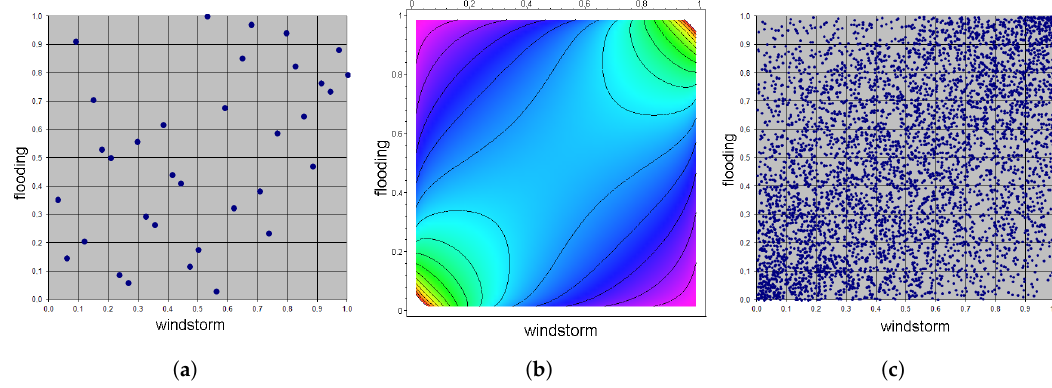
Figure 6. Plots for the Gaussian copula in Example 3. ( a ) Support points of scaled skeleton. ( b ) Gaussian copula density contour plot. ( c ) Simulation of 5000 Gaussian copula pairs.